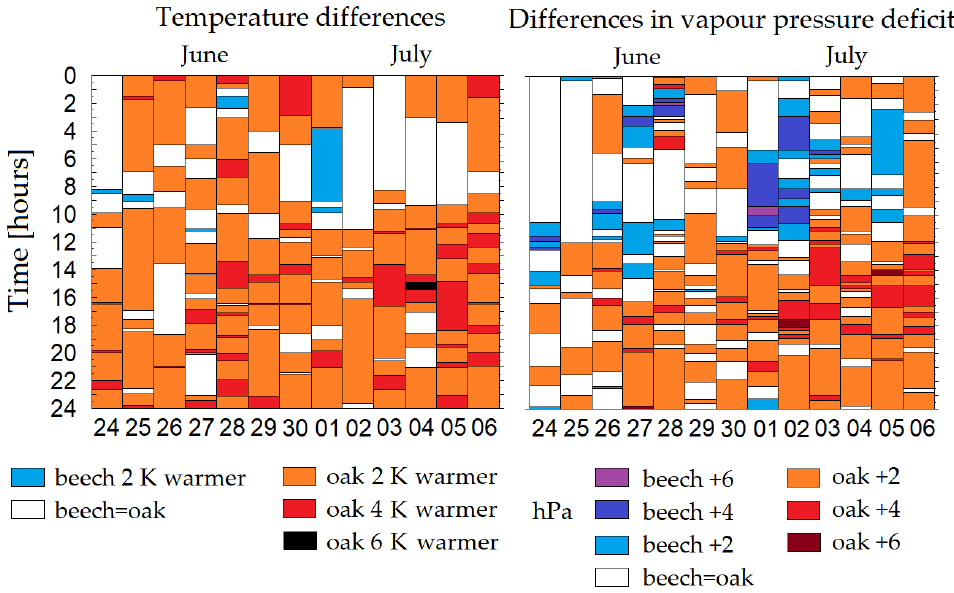
Figure 6. Differences in air temperature ( left ) and vpd ( right ) between the oak and beech forests of the Eşelniţa transect in their diurnal course over 13 days in summer 2019 (24 June–6 July). The vpd difference is given in hPa. Note that the oak forest interior is most of the day 2–6 K warmer than the beech forest, especially in the afternoon. vpd is higher in the oak forest especially in the afternoon and early night, while vpd is higher in the beech forest on several days late in the night and in the morning.